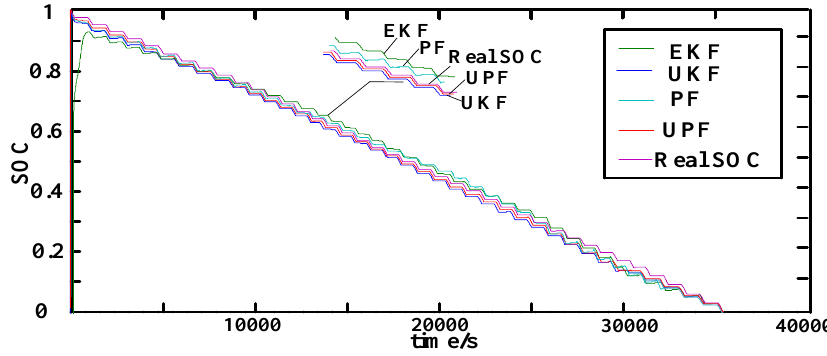
Figure 14. SOC estimation of di ff erent algorithms at − 10 ◦ C. Table 8. Maximum Estimation Error of Different Algorithms at −10 °C.